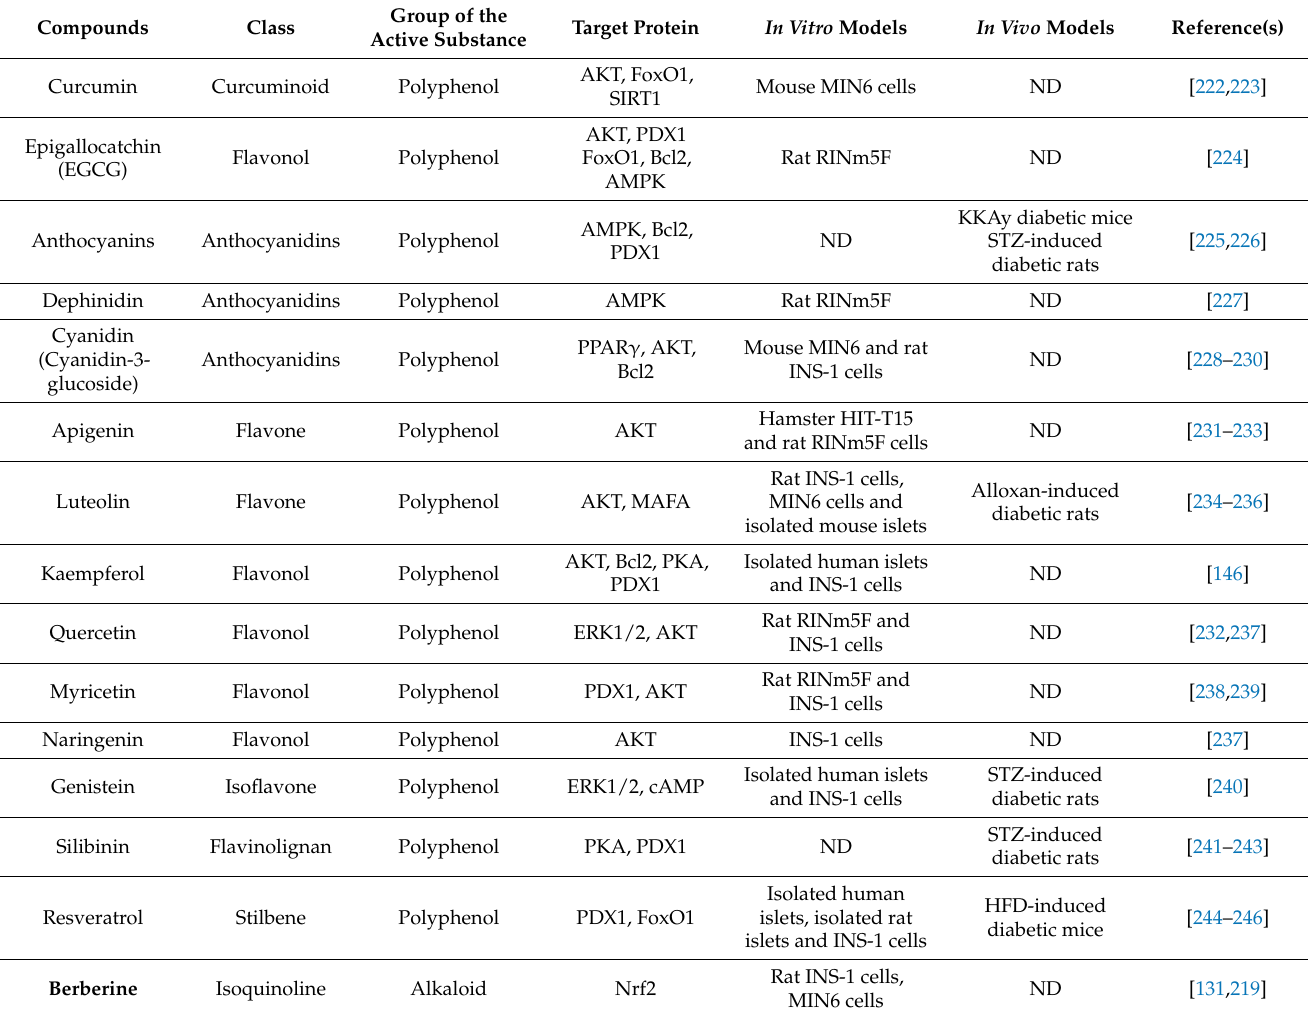
Table 7. Polyphenols and alkaloids targeting β -cell survival